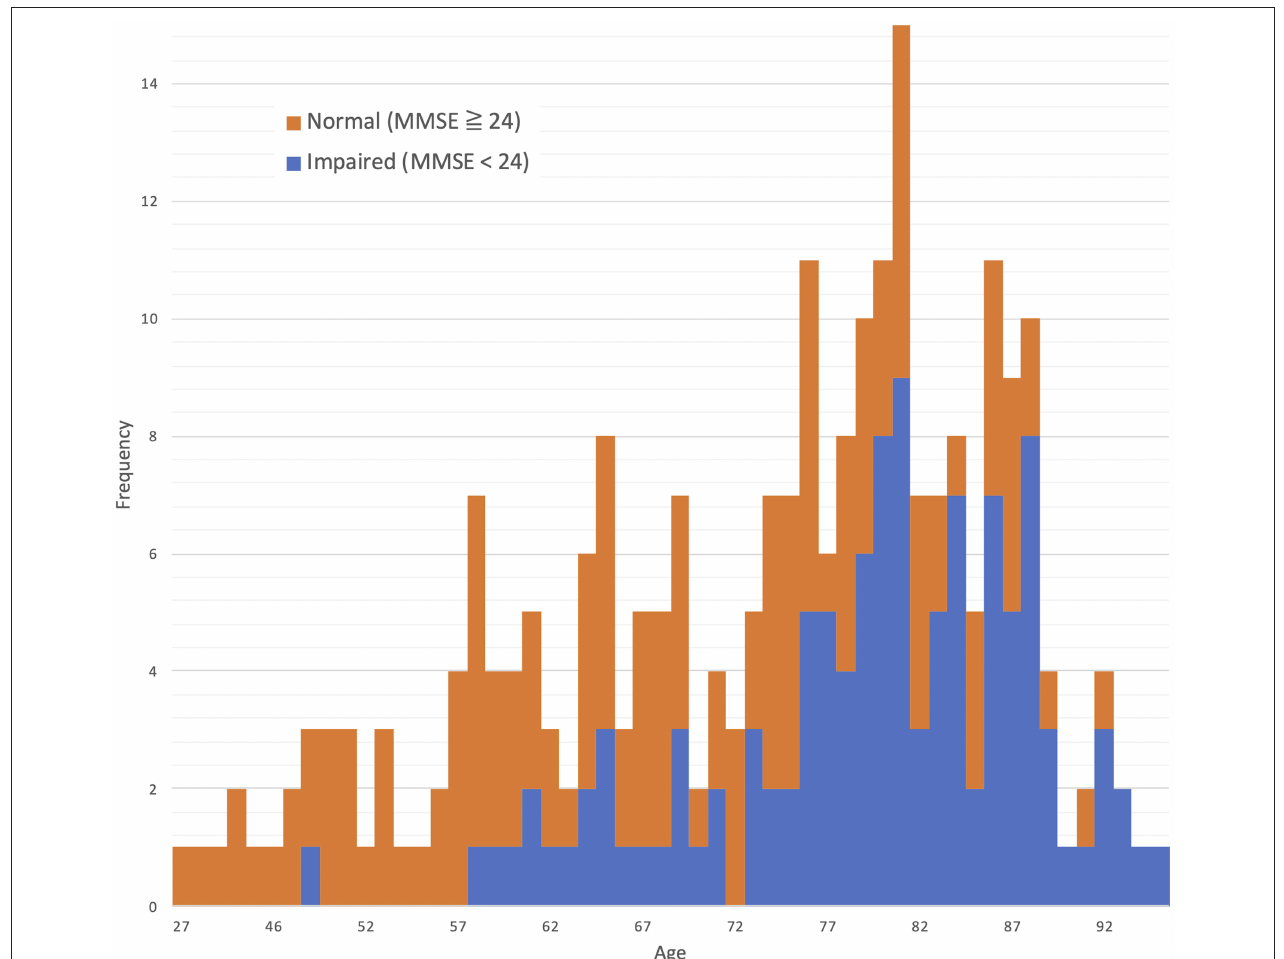
FIGURE 1 | Age distribution: 73.3 ± 12.6 (mean ±